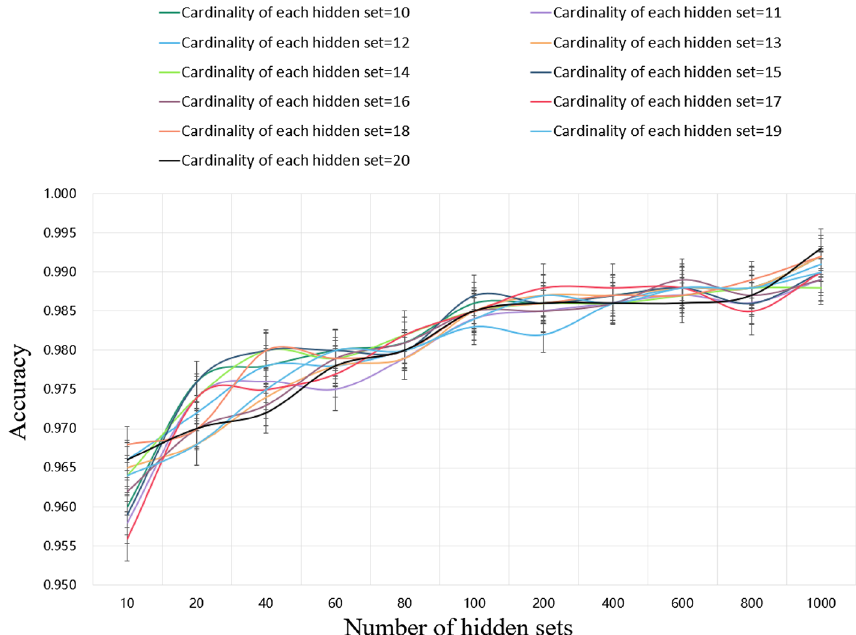
Figure 7. The accuracy of the improved RepSet model for the classification of four regional Maojian with different number of hidden sets and different cardinality of hidden sets.